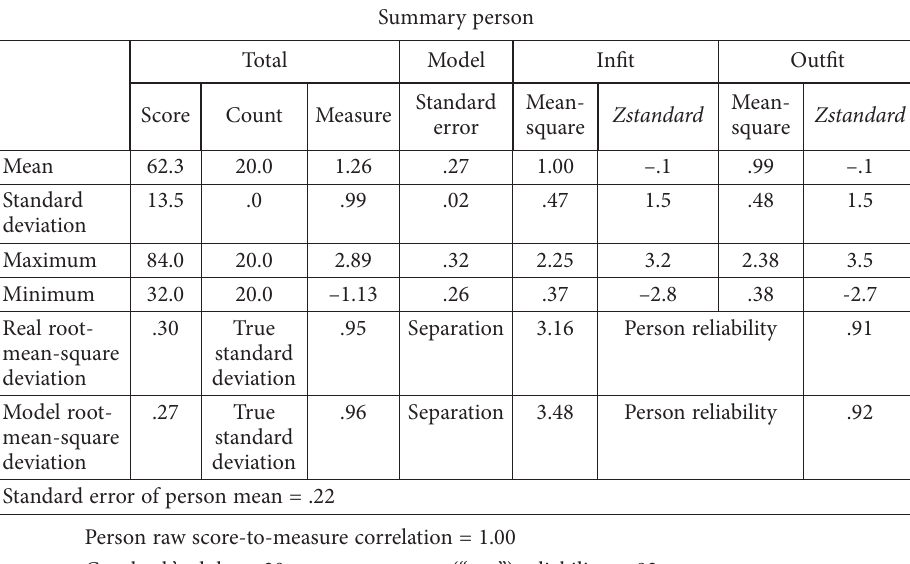
Table 7. Summary statistic (source: created by